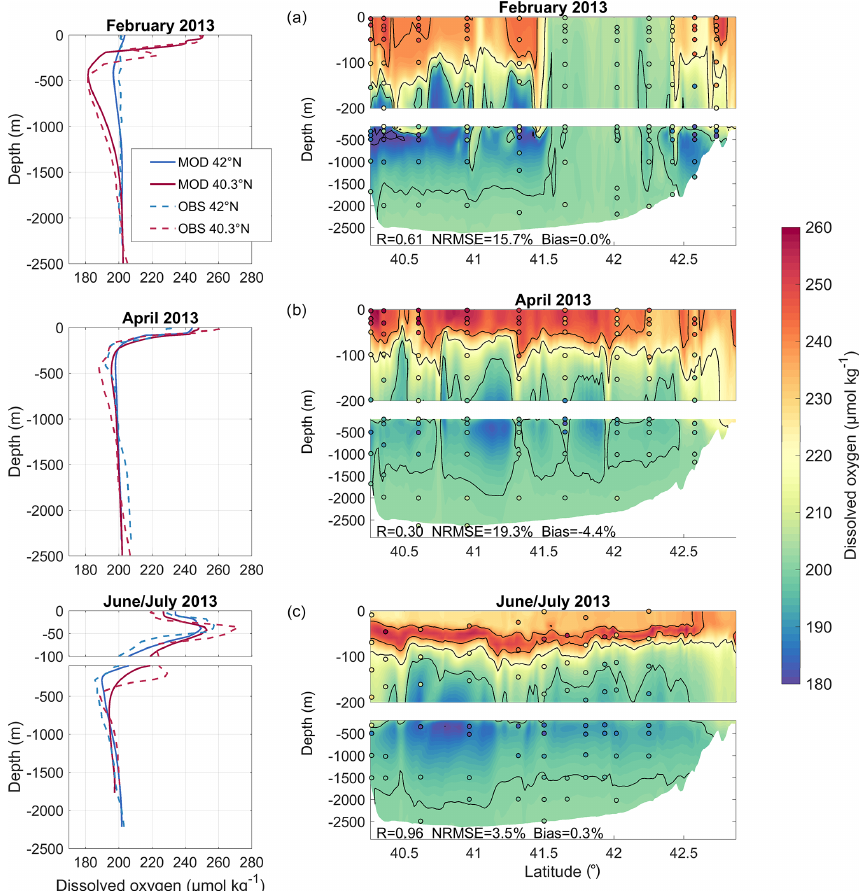
Figure 4. Comparison between model outputs and observations on a transect crossing the deep-convection area (stations are circled in black in Fig. 3a, c and e) over the ( a and b ) DEWEX (Leg1: 10–12 February 2013, Leg2: 8–10 April) and (c) MOOSE-GE (27 June–5 July 2013) cruise periods. The left column shows observed and modelled profiles at 42 and 40.3 ◦ N. The right column shows vertical section of dissolved oxygen concentration (µmolkg − 1 ) along the transect; the model is represented by background colours and observations are indicated in coloured